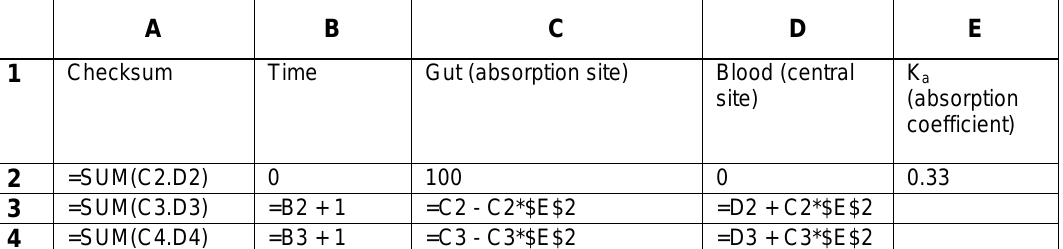
Spreadsheet Formulae for Simulation of First-Order